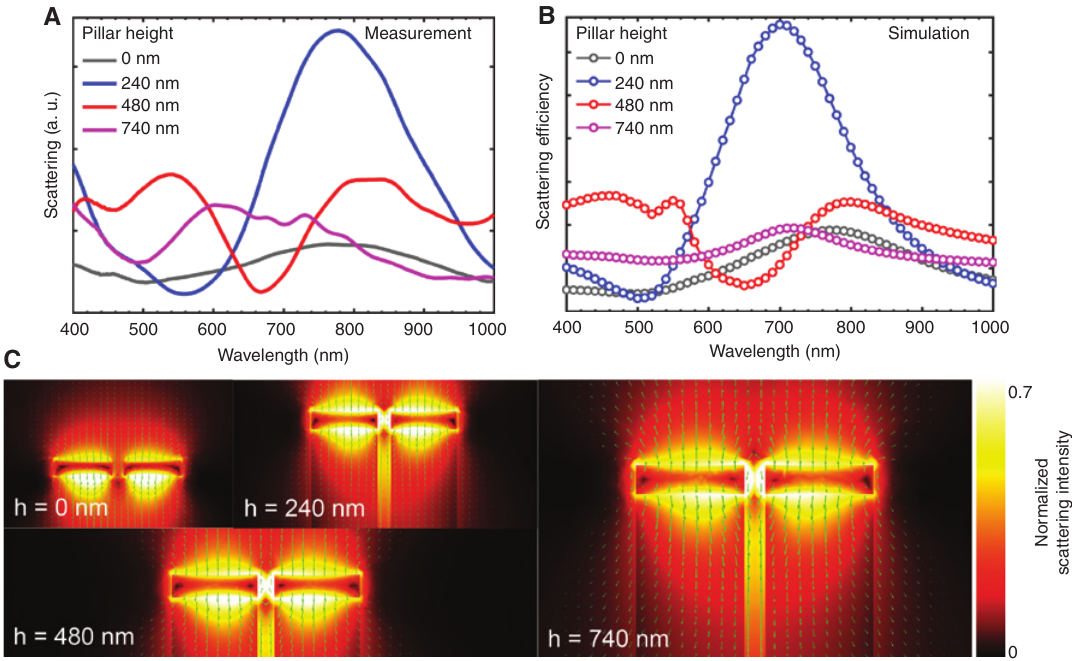
Figure 3: Scattering spectra of 150 nm diameter nanoantenna dimers with a gap of 30 nm on top of nanopillars of various height. (A) Comparison between measured scattering spectra of 0 nm, 240 nm, 480 nm, and 740 nm tall nanopillar dimers. A clear enhancement is observed when placing the antennas on 240 nm tall pillars, but the degree of enhancement decreases for taller heights, which is due to a significant portion of the light being scattered at larger angles than the forward direction. (B) Corresponding simulated spectra of the data shown in (A). By only taking forward scattered light into consideration and coming with an angle equal to that of the dark-field condenser, the simulated spectra show reasonable agreement with experimental spectra. (C) Plots of the intensity and power flow of the scattering of a nanoantenna dimer for various pillar heights at an excitation wavelength of 800 nm, plotted in the center transverse plane of the structures. A portion of the light is scattered at larger angles due to the interface between gold and glass, which will alter the forward scattered